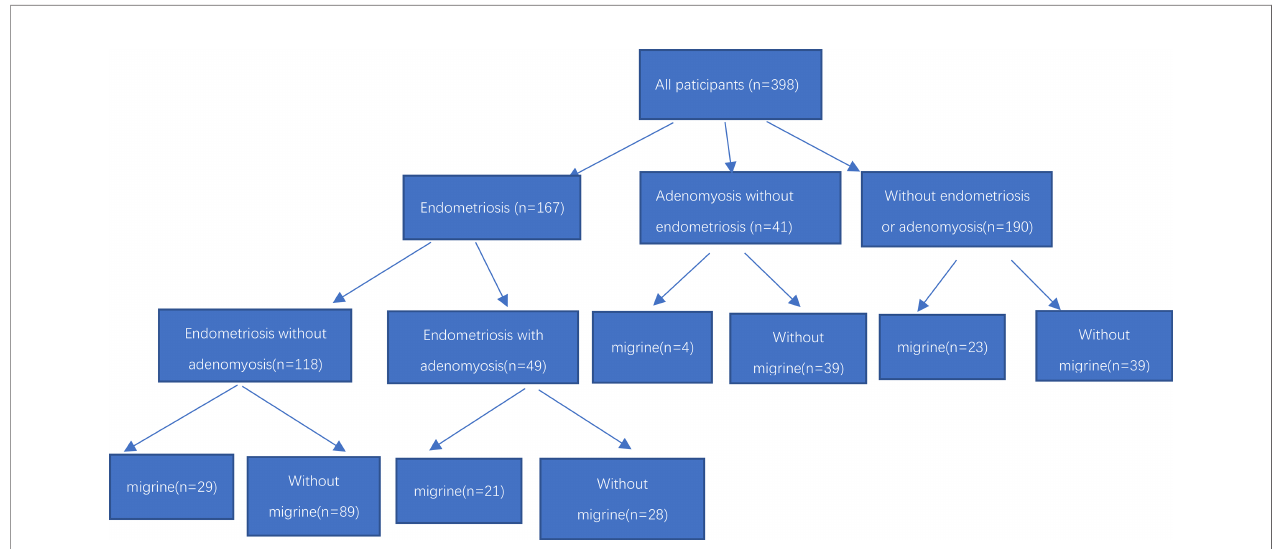
FIGURE 1 | Flowchart inclusion of